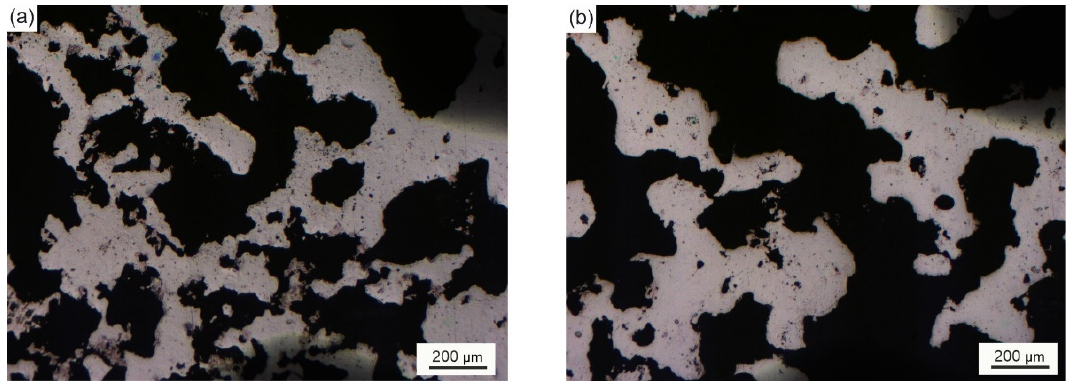
Figure 2. Optical images of the macrostructure of porous NiTi-(Ar) ( a ) and NiTi-(N) ( b ) alloys.